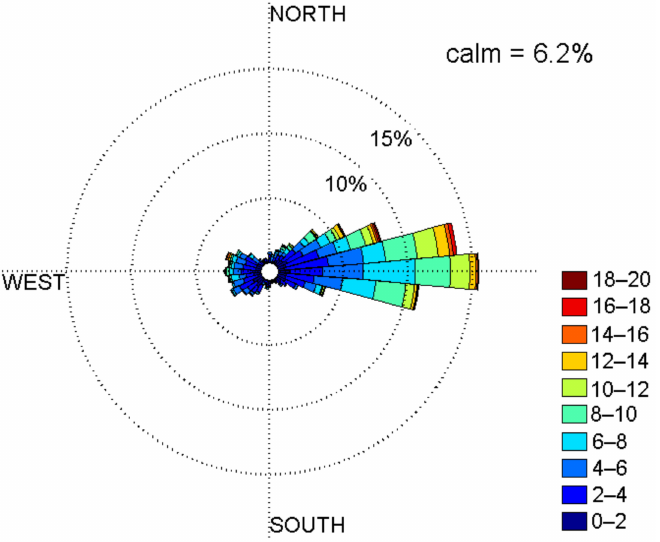
Figure 8. Wind rose showing wind from Hornsund station for the 1994–2013 when the large-scale wind velocity is 0–2 ms − 1